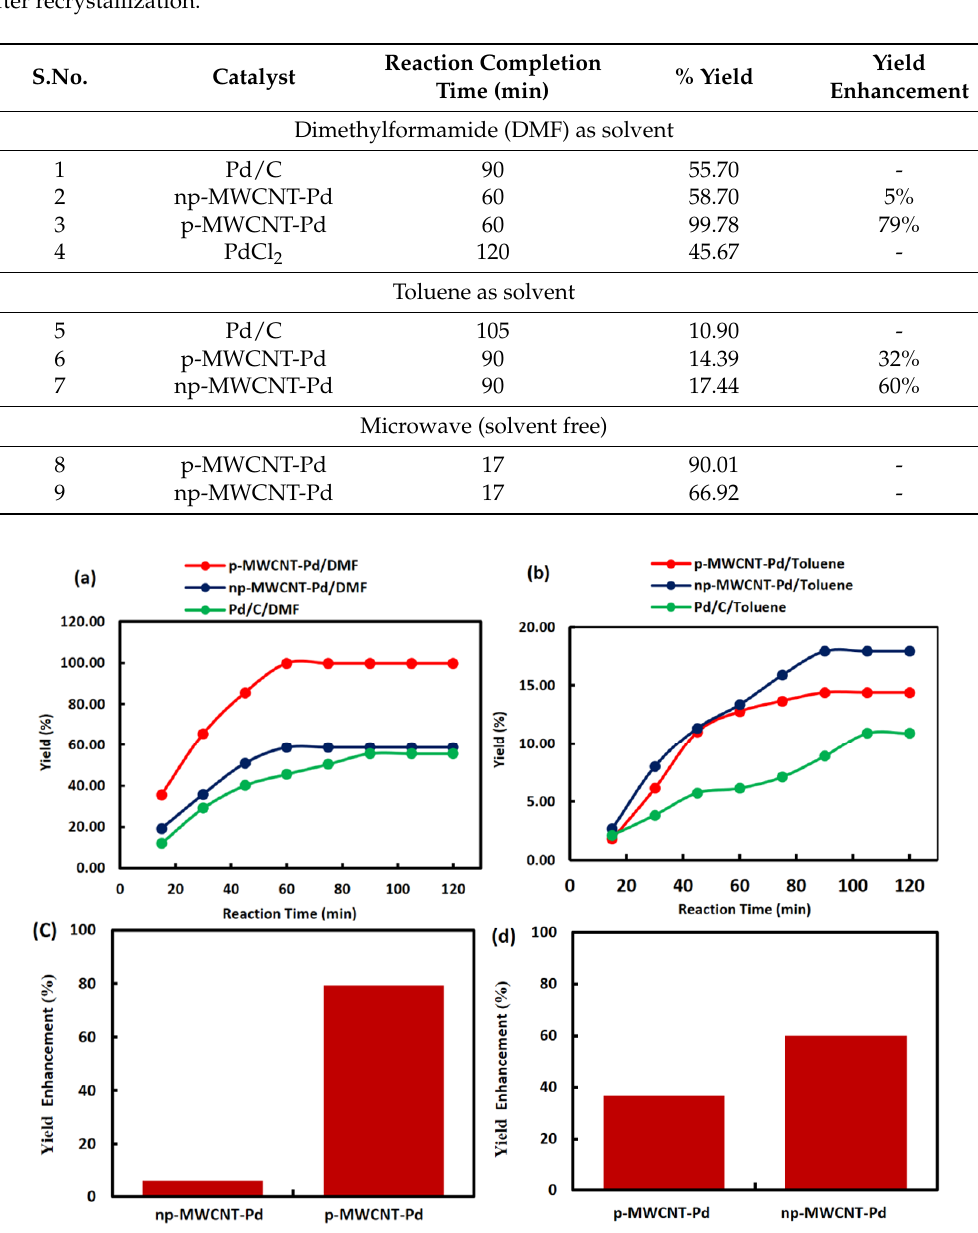
Figure 6. Yields of the CNT-metal nanohybrids and Pd/C catalyzed reactions ( a ) in DMF and ( b ) in toluene from GC analysis (Tri-butyl amine as base, temp 150 °C); ( c ) yield enhancement with respect to Pd/C in DMF; ( d ) enhancement with respect to Pd/C in toluene.